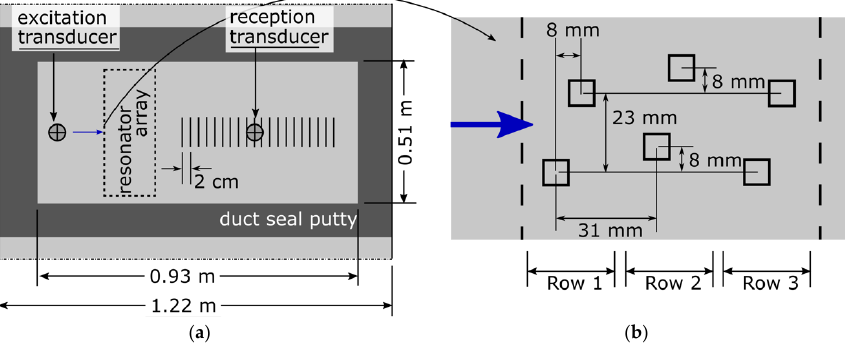
Figure 1. Schematic (not to scale) of experimental setup: ( a ) top-view of the transducer positions with respect to the resonator array, and ( b ) a zoomed in view of the resonator array that shows how the resonators are positioned with respect the wave-propagation direction. The squares are the contact areas between the resonators and the plate waveguide.